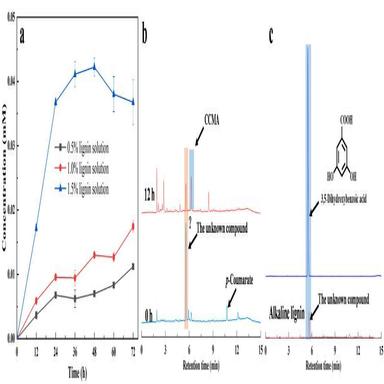
CCMA production from alkaline lignin and characterization of an unidentified compound isolated from CSHs. (a) The effects of CCMA production from a gradient concentration of alkaline lignin solution; (b) HPLC examination of the CCMA production from alkaline lignin solution, with the CCMA and the unidentified compound labeled; (c) The unidentified compound matched 3,5-hydroxybenzoic acid via HPLC analysis.